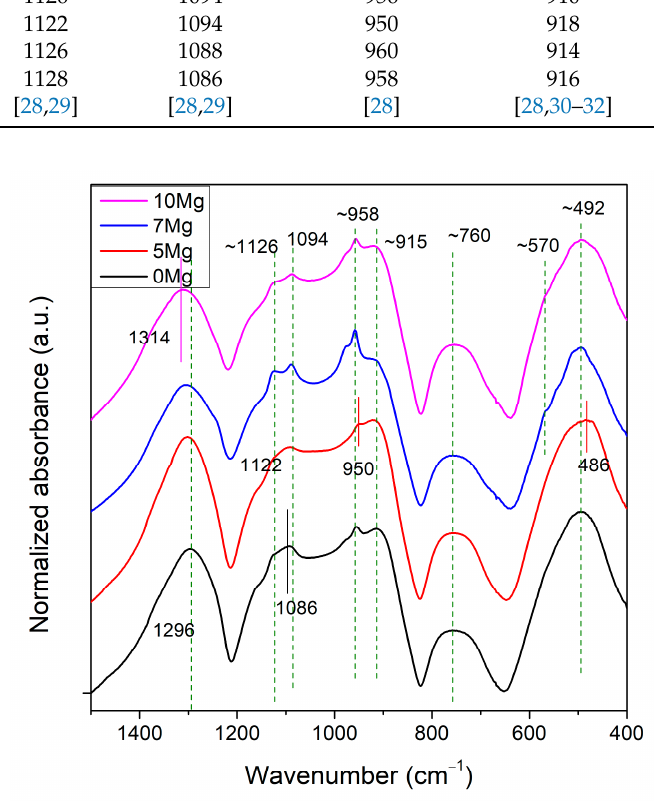
Figure 3. FTIR spectra for all samples.